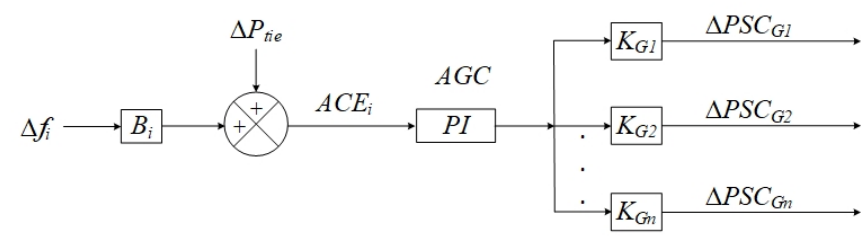
Figure 1. Control block diagram for automatic generation control (AGC).